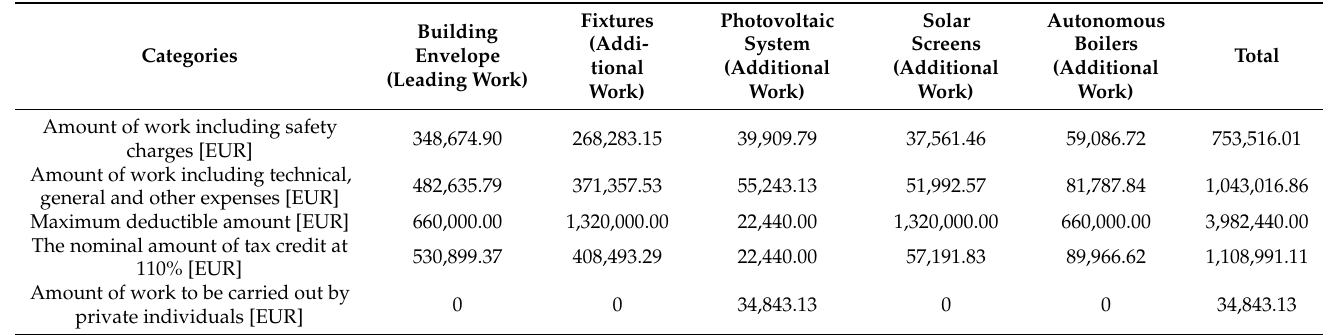
Table 4. Summary of the economic project framework, cost allocation scheme between the ESCo and private individuals, and a statement of the amounts subject to tax deduction within the maximum spending